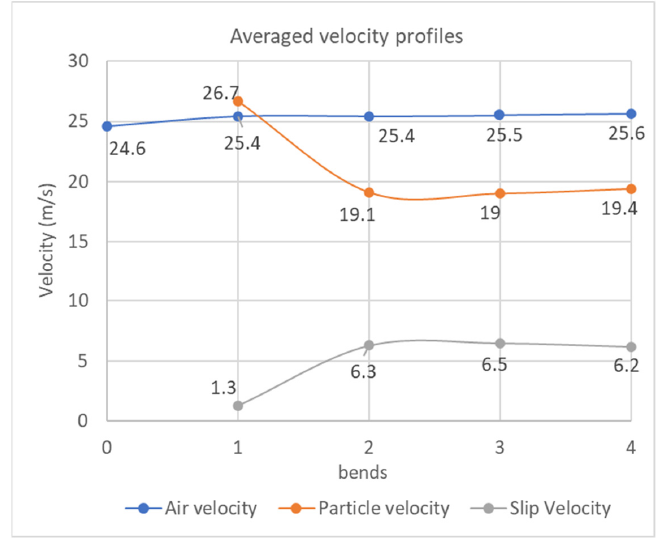
Figure 6. Velocity profiles for coffee beans at 0.27 kg/s air mass flow rate and 0.2 kg/s solid flow rate. Table 11. Degradation of coffee beans with an air flow rate of 0.27 kg/s and feeder speed of 10 RPM while conveying through a pipeline having bends in proximity.